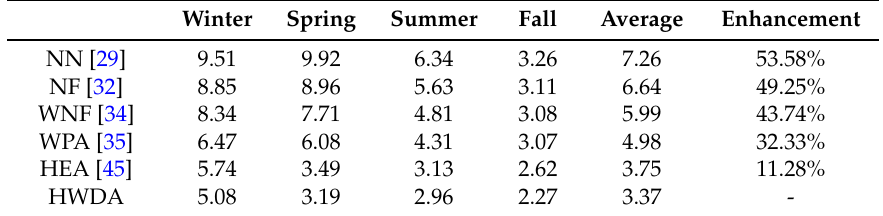
Table 6. MAPE (the mean absolute percentage error) comparison for wind power forecasting.